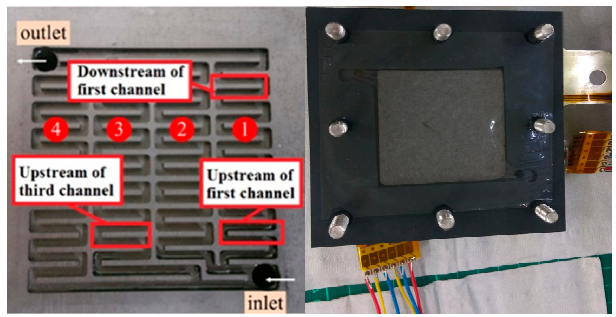
Figure 10. Numbers and locations of anode channels of the VRFB.